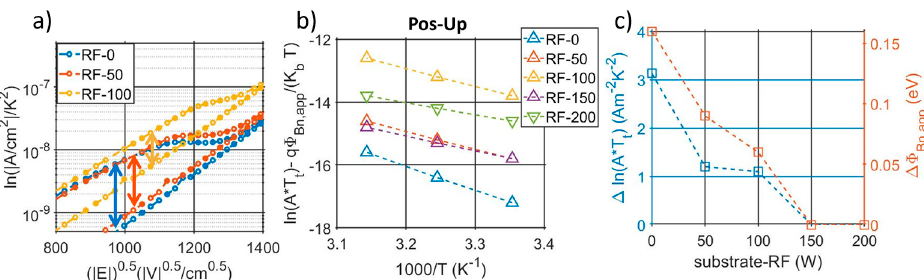
Figure 10. ( a ) Zoom-in of the ln(J/T 2 ) vs. √ E characteristic around the transition fields with positive bias applied per RF-0, RF-50, and RF-100. The arrows indicate the difference between the two resistive states of the films corresponding to the two polarity states of the films. ( b ) Extracted intercepts per different temperatures to evaluate the induced barrier variations with a positive bias applied to the up-polarization state. Figure S4 in supplemental material shows the intercept variations corresponding to the opposite polarity state. ( c ) Impact of the substrate-RF on the polarization-dependent resistive behavior: the left axis shows the difference between the extracted up-polarity ln(A × T) and down-polarity ln(A × T), while the right axis plots the same difference calculated for the apparent barrier. Additionally, the switching currents, in output of the same input voltage, exhibit not only different voltage thresholds (i.e., voltage for which the current rises